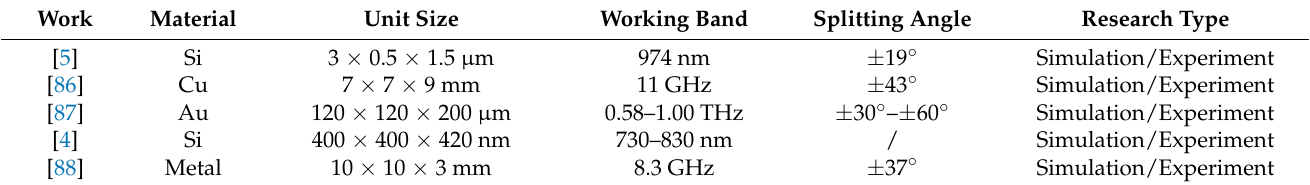
Figure 7. ( a ) Schematic diagram of the beam splitter for a Rochon−like prism. Reprinted with permission from [4]. Copyright 2018 American Chemical Society. ( b ) Far-field intensity distribution under LCP ( i ) and RCP ( ii ) incidences. Reprinted with permission from [4]. Copyright 2018 American Chemical Society. ( c ) Schematic of the bilayer metasurface ( i ), with top ( ii ) and bottom ( iii ) views [88]. ( d ) ( i , ii ) Performance of a reflective circular polarization beam splitter, given the normalized scattering intensity as a function of frequency and detection angle [88]. Table 2. Parameters of circular polarization metasurface beam splitters described in this section.